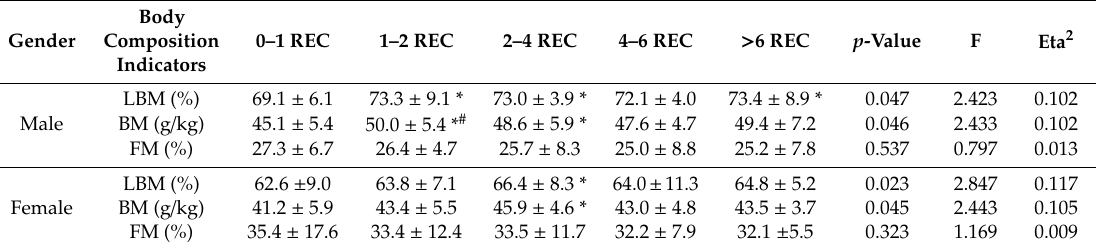
Table 3. The LBM, BM, and FM of participants with di ff erent multiples of PA recommendation.